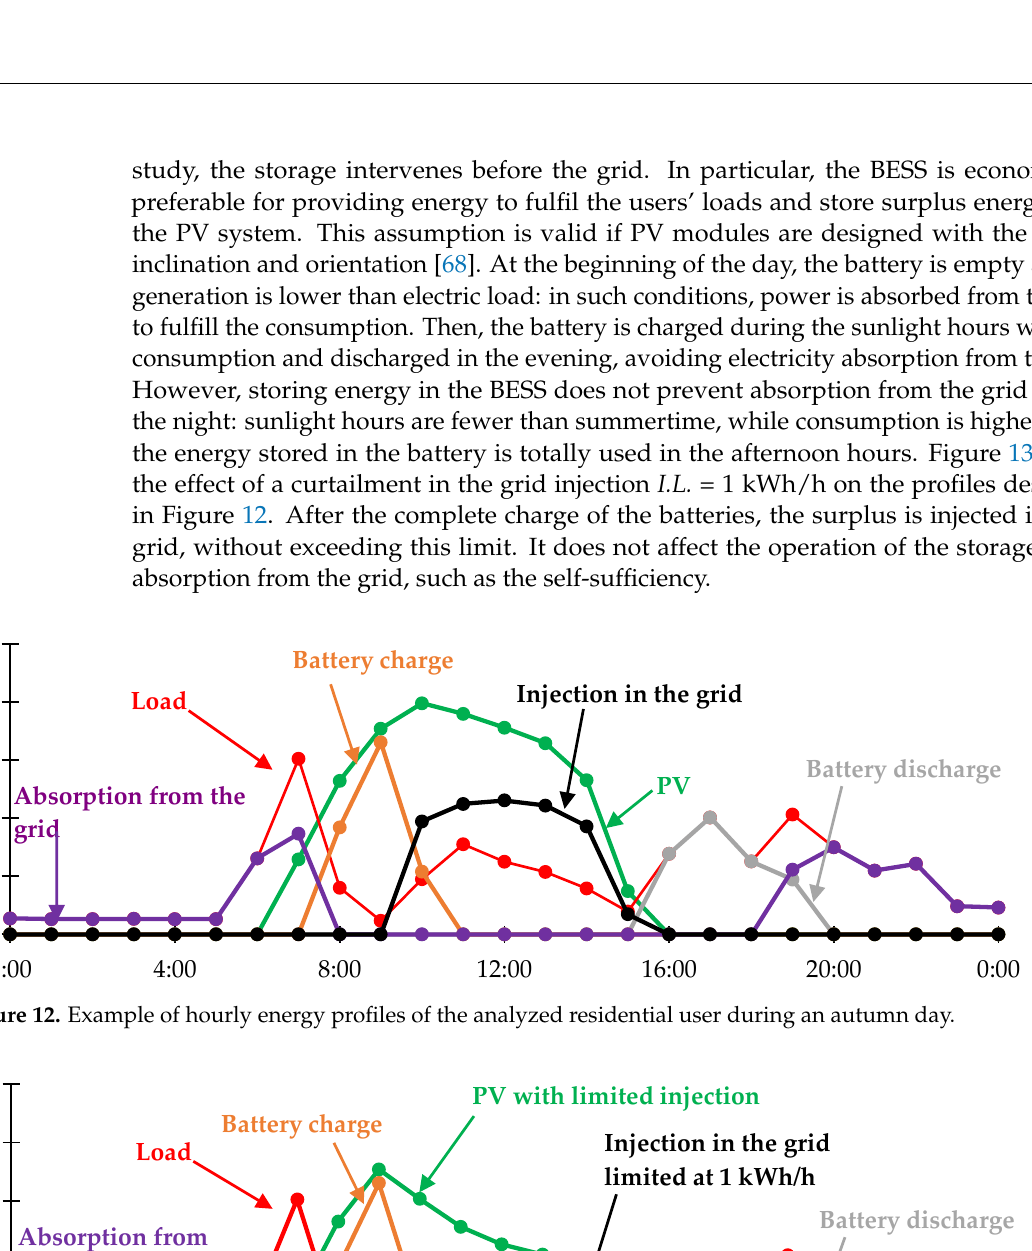
tion of the sizes of the plants. The simulation shows that the introduction of the limit on power injection into the grid impacts the SS optimization for thresholds lower than 3 kWh/h. In particular, in the configuration without injection, the maximum SS is 52%, achieved with a PV system of 4 kW and a battery capacity of 4 kWh. Over the 3 kWh/h limit, the optimal solution corresponds to the case without injection limits (PV system of 7 kW and BESS of 6 kWh). The achieved SS is 65% and this quantity shows an asymptotic trend due to an economic reason: a further increase in PV or battery size is not cost-effective because the IRR becomes lower than its minimum